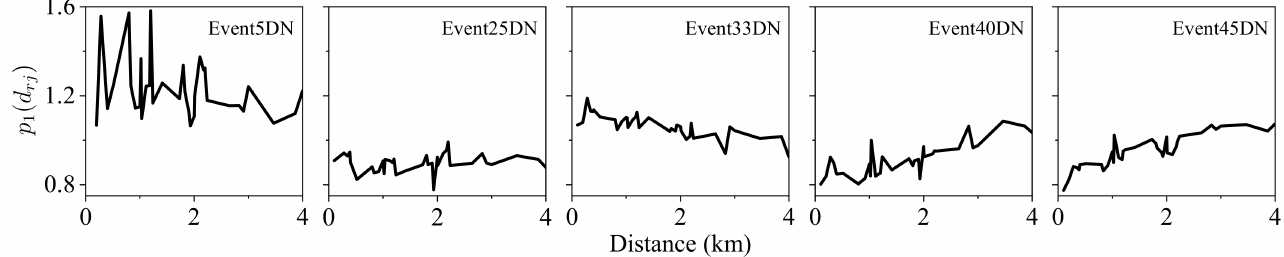
(cid:16) (cid:17) d rj for the vertical